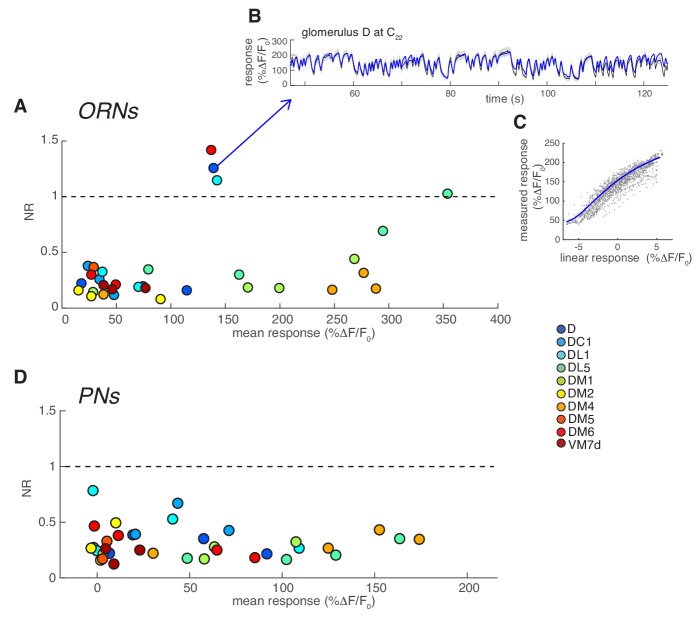
Residual-to-noise ratio in LN model cross-validation.(A) Residual-to-noise ratio (NR) calculated as described in Materials and methods for ORN responses measured in 10 glomeruli at 4 concentrations of two odors (methyl acetate and benzaldehyde) and plotted as a function of the mean response. NR <1 indicates that the residuals of the LN model are within the variability across trials. Only in four cases NR >1. (B) Details of the model estimate for one of the recordings for which NR >1. Black: mean response of ORNs in glomerulus D to high concentration of benzaldehyde. Shaded area: SEM. Blue: prediction of the LN model showing a slight mismatch in the last 20 s of the response. (C) Measured response as a function of predicted linear response (gray dots) and fitted static function (blue line). Dots far from the curve are time points of D response that are less well fitted by the LNL model. These data show that even a poorly performing LNL model can qualitatively describe the glomerulus response. These responses were included in further analysis. (D) NR for PNs is always <1. Overall there is no obvious dependency of model prediction and response amplitude, suggesting that increased non-linearity in the response is well captured by the LN model.